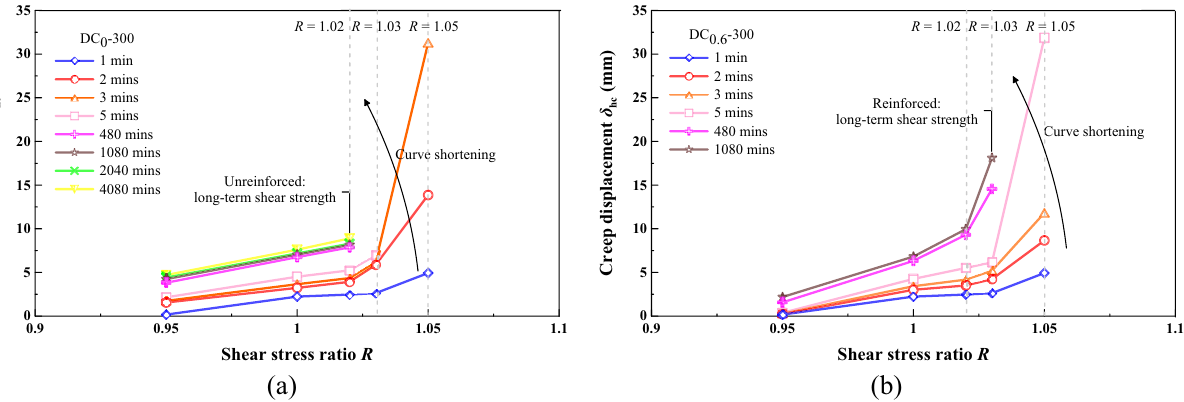
Figure 15. Isochronal curve for ( a ) unreinforced specimen under σ n = 300 kPa and ( b ) reinforced specimen under σ n = 300 kPa.